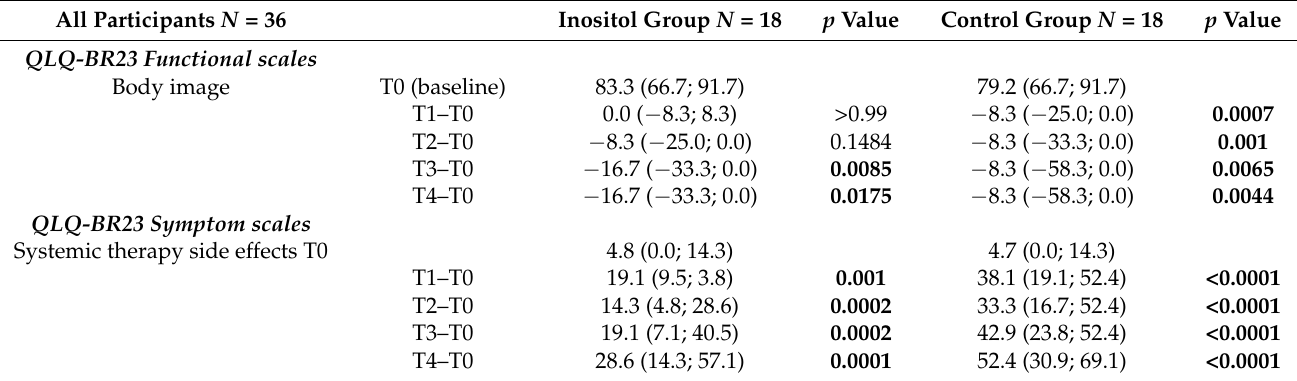
Table 2. Variations of QLQ-BR23 questionnaires’ scores from baseline (T0) to T1-T4 in the Inositol Group and in the Control